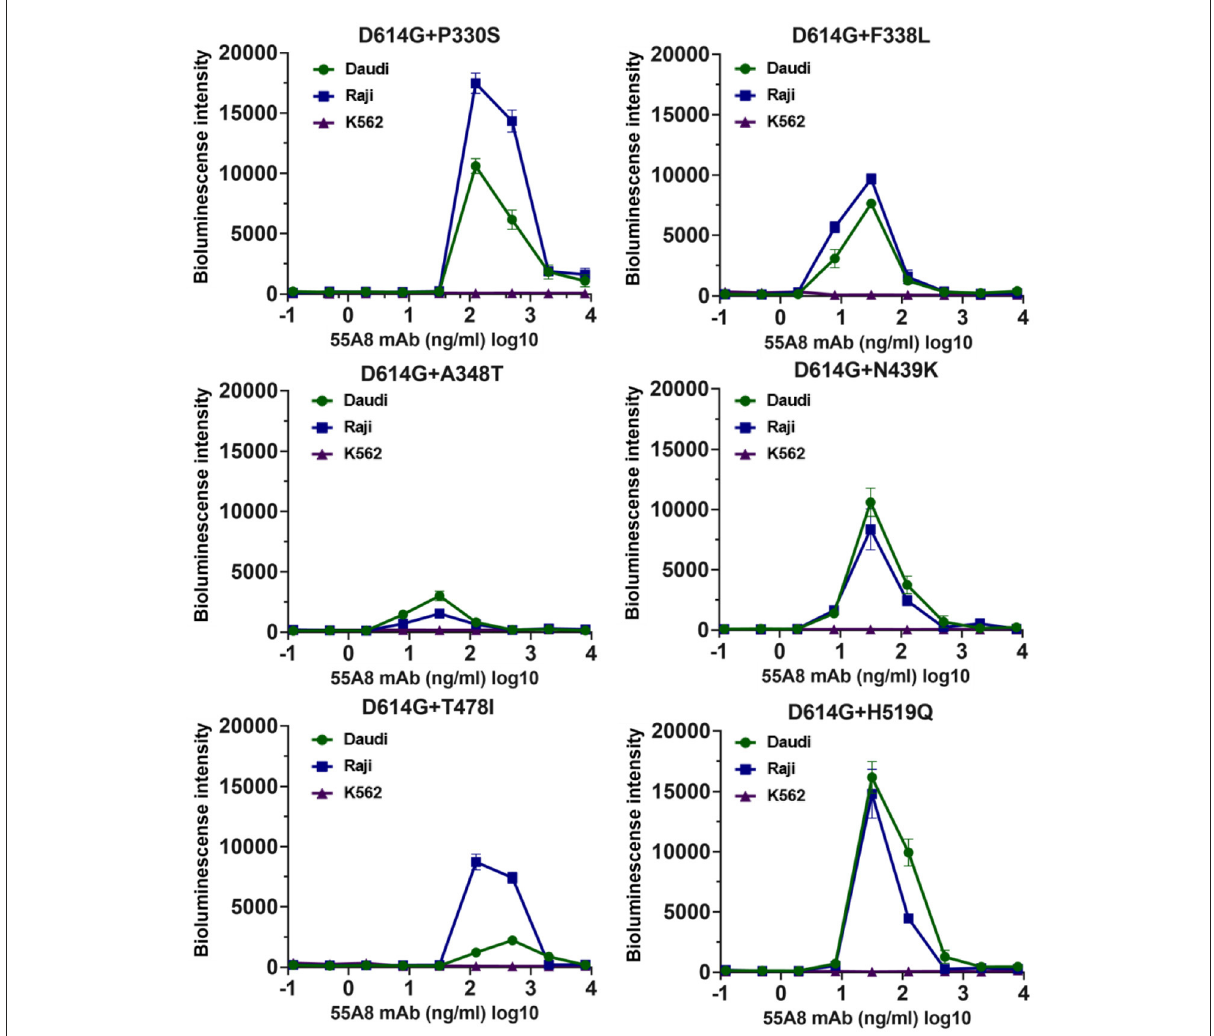
FIGURE3 ADE activities of the neutralizing antibody 55A8 for the high-infective double-mutant variants. The highly infectious double-mutant variants included D614G + P330S, D614G + F338L, D614G + A348T, D614G + N439K, D614G + T478I, and D614G + H519Q. Pseudoviruses were preincubated with serial dilutions of 55A8 mAbs, and these mixtures were added to Daudi, Raji, and K562 cells to evaluate their ability to enhance infection. RLU values resulting from infection with variant pseudotyped viruses were quantified by a luminescence meter. Data for each NAb were obtained from a representative infectivity experiment of three replicates and presented as the mean values ±